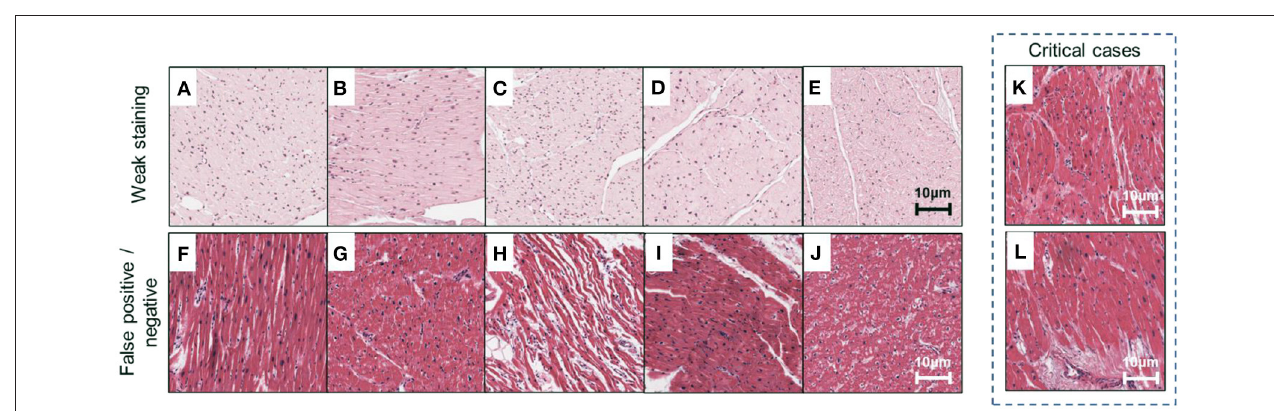
FIGURE 8 | Examples of misclassified cases. Representative ROIs are used as examples to demonstrate two types of misclassification marked in Figure 6 . (A–E) Weak staining; (F–I) false-positive cases; (J) false-negative cases; (K,L) critical cases are correctly classified but confirmed to exhibit severe local injury and receive high-risk scores. Scale bars: 10 µ